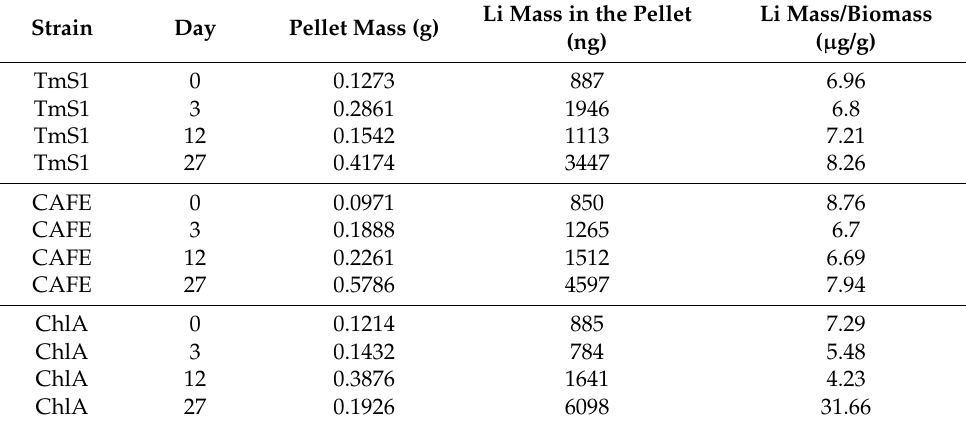
Table 2. Li-mass quantification in each experimental pellet.